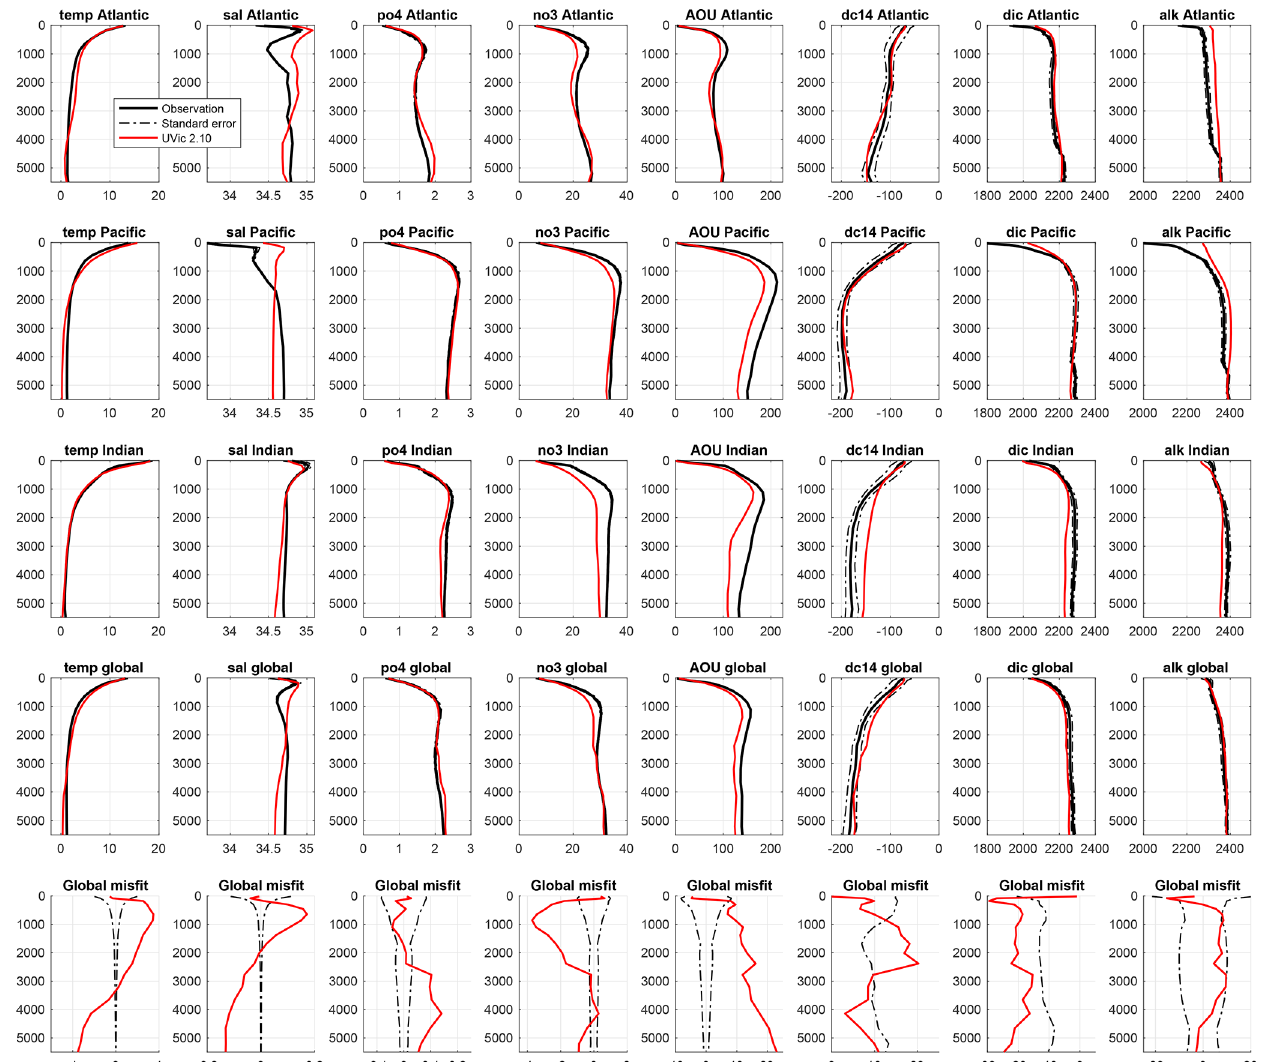
Figure 11. Global and basin-wide averaged vertical profiles of multiple UVic ESCM 2.10 metrics (red lines) compared to observations from the World Ocean Atlas 2018 (Locarnini et al., 2018; Zweng et al., 2019; Garcia et al., 2018a, b) and GLODAP and GLODAP mapped climatologies v2.2016b (Key et al., 2004; Lauvset et al., 2016), including standard errors (solid and dashed black lines, respectively) and their respective global misfit (last row) for the period of 1980–2010. Note that for salinity we excluded the fresh water masses observed in the Arctic Ocean (i.e. all values north of 70 ◦ N for both